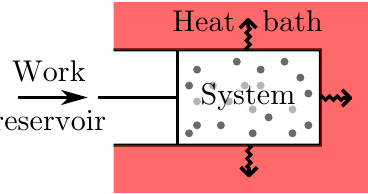
FIG. 1. Thermodynamic setup where the system is a gas in a container. By pushing a piston, the thermodynamic variables (such as T , p , or V ) can be changed in a mechanically con- trolled way, which is abstracted as the action of a “work reser- voir.” Furthermore, through the walls of the container the gas is in simultaneous contact with a heat bath, with which it can exchange energy. This exchange of energy is accompanied with an exchange of entropy, which is the defining property to call this energy exchange